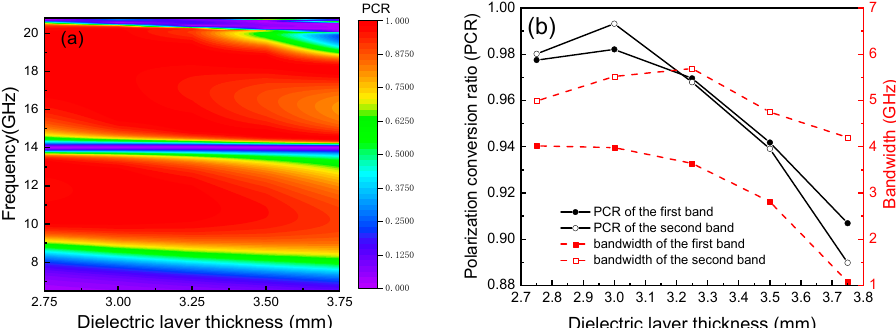
Figure 6. ( a ) PCR for various dielectric layer thicknesses. ( b ) PCR and bandwidth characteristics for the two frequency ranges with various dielectric layer thicknesses.